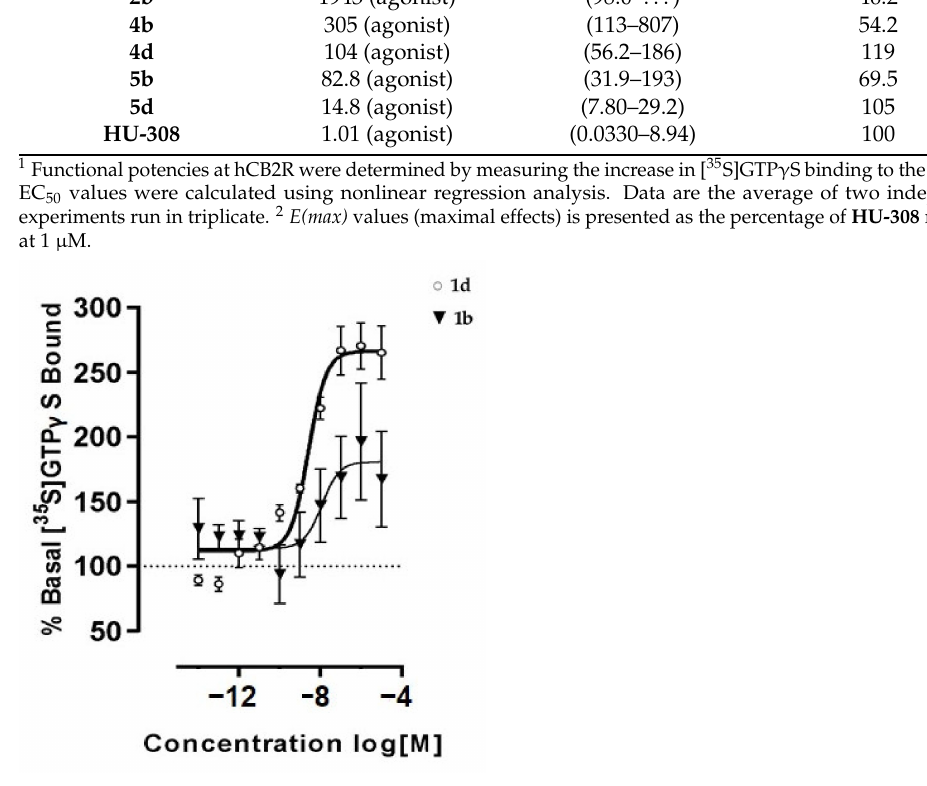
Figure 5. Mean log concentration–response curves of 1b and 1d for stimulation of [ 35 S]GTP γ S binding to hCB2R CHO cell membranes. Each symbol represents the mean percentage increase in [ 35 S]GTP γ S binding ±